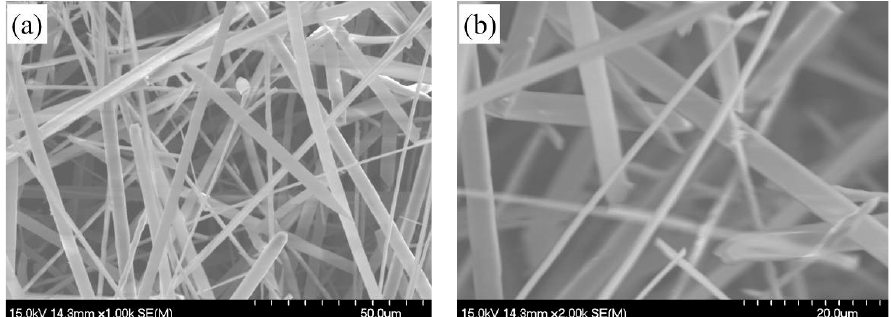
Figure 2 . Micromorphologies of α‐ Si 3 N 4 belts ( a ) 50.0 μ m; ( b ) 20.0 μ m.